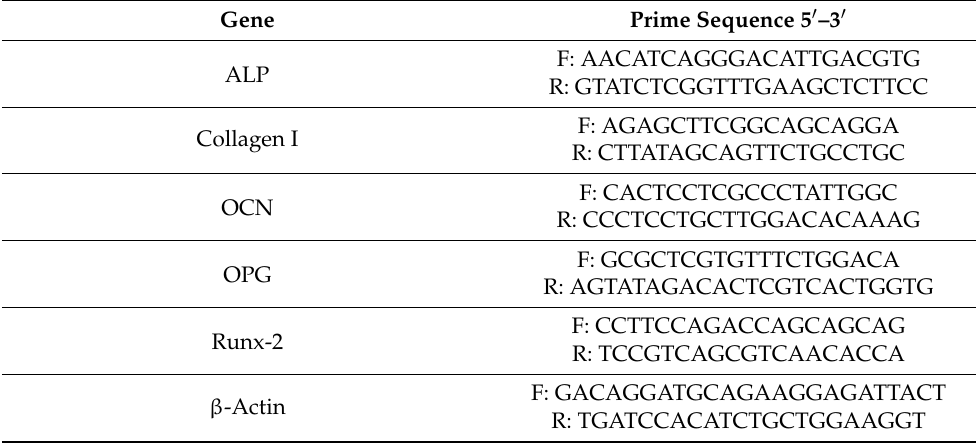
Table 1. Primer sequences used in real-time PCR